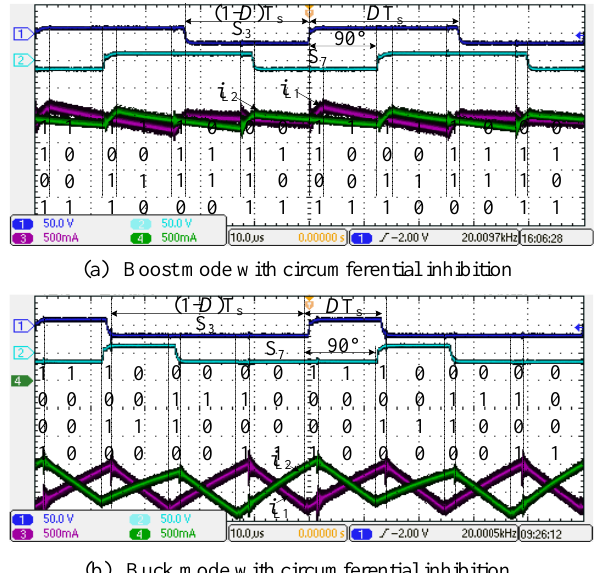
Figure 8. Left and right arms interleaved 90 º parallel without circumferential inhibition. ( a ) Boost mode. ( b ) Buck mode.